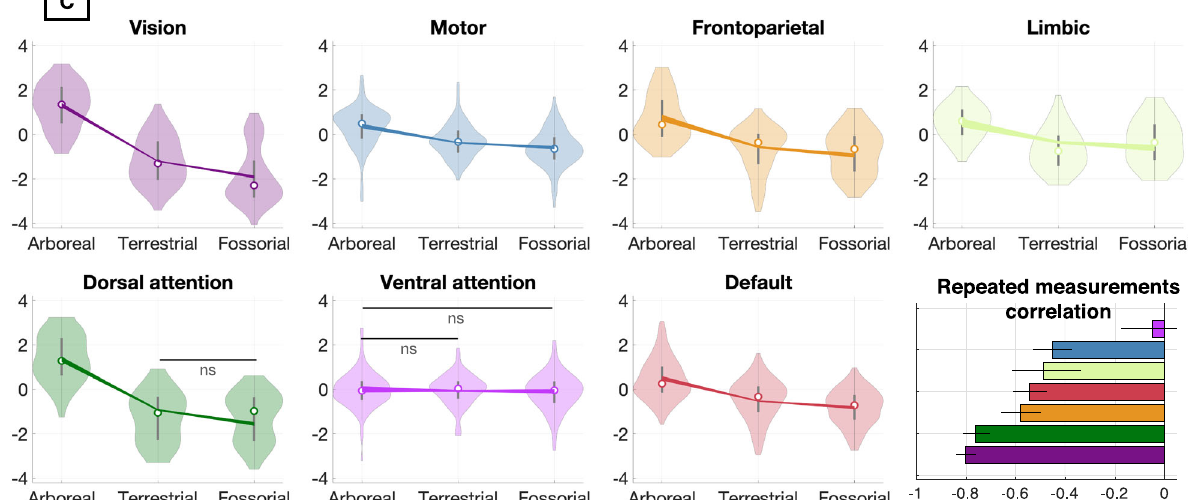
Fig. 4 | The correlation structure between expansion patterns associated with ecological and behavioural variables reveals a putative ordering of cortical adaptation to habitat complexity. a We used two-sided Pearson correlation ( n =21, the number of pPCA dimensions used in the analysis) between the matrices ofpairwiseeffectmeasuresofeachobservedecologicalandbehaviouralvariableto highlight the ordered nature of the effect of habitat complexity on the differential expansion of cortical areas. Signi fi cant correlation are indicated by * p <0.05, ** p <0.01,*** p <0.001.StatisticalinformationisprovidedinSupplementaryData4a. b Computation of relative measurement correlation requires a metric for the explanatory variables of the individual groups. A measure for the relative habitat complexity of fossorial species ( − 0.278) is computed from a tentative ordering of habitat complexity and by fi xing the two more complex habitats that contain “ arboreal ” (1) and “ terrestrial ” (0) species. This scaling is applied globally to all